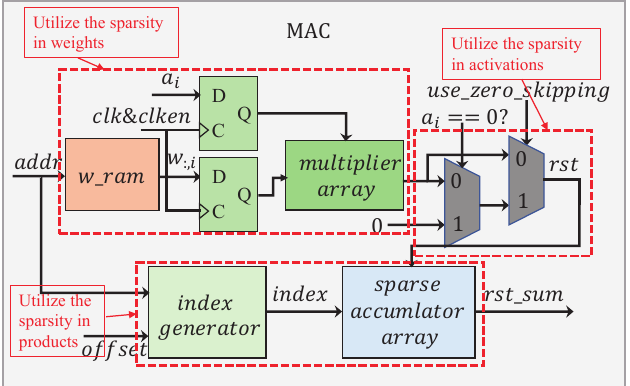
Figure 13. The processing flow of Module multiply and accumulate